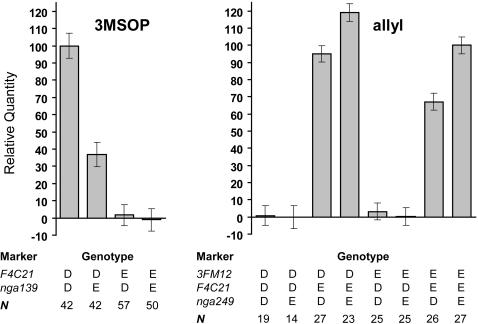
Epistatic interactions in the biosynthesis of homomethionine-derived glucosinolates.Left: 3-methylsulfinylpropyl glucosinolate (3MSOP) is produced when the genotype at the AOP locus (marker F4C21) is Da(1)-12. An Ei-2 allele at marker nga139 reduces the accumulation of this glucosinolate by 60%. Right: allyl glucosinolate is produced when the genotype at AOP is Ei-2. A Da(1)-12 allele at 3FM12 increases and a Da(1)-12 allele at nga249 decreases leaf allyl glucosinolate accumulation. N indicates the number of RILs with a particular combination of genotypes at the different markers.